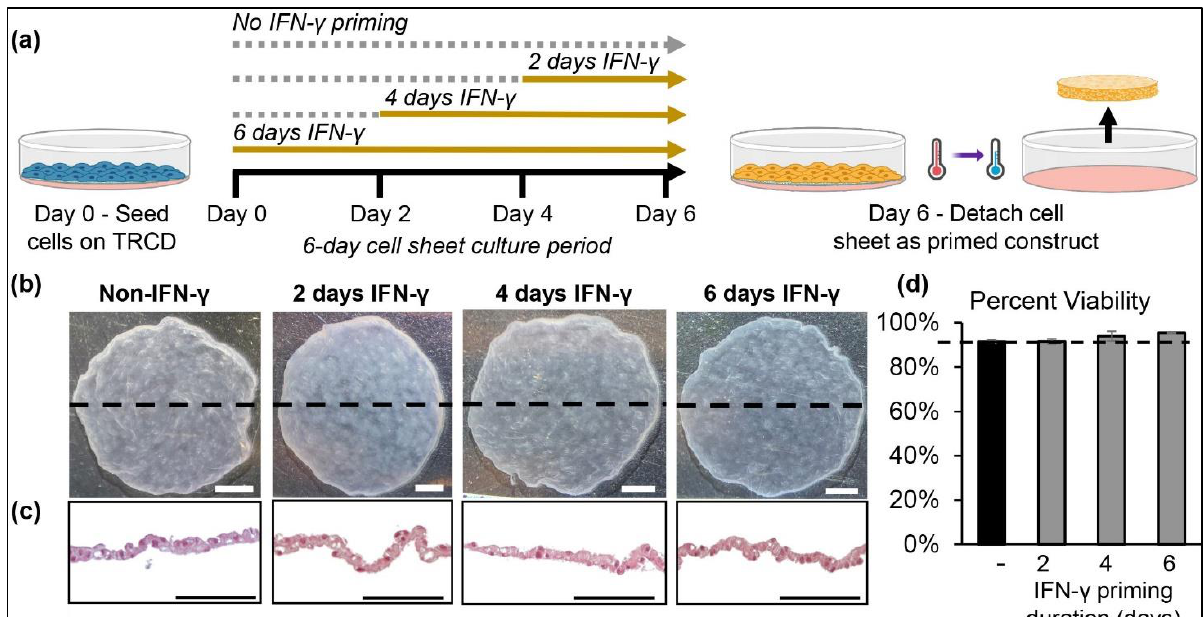
Figure 1. hcBMSCs readily detach as 3D sheets after treatment with IFN- γ. ( a ) Experimental schematic of fabrication of IFN- γ primed hcBMSC sheets with IFN- γ added at different timepoints of the 6-day cell sheet culture to elicit different priming durations. ( b ) Representative macroscopic images of detached 3D contracted cell sheet constructs (scale bar = 2 mm). ( c ) Representative cross-sectional hematoxylin and eosin staining of non-primed and primed cell sheet constructs (scale bar = 100 µm). ( d ) Cell viability of non-primed and primed cell sheets after temperature-mediated detachment ( n = 2). Dotted line = 90%. Error bars represent means ± SE.